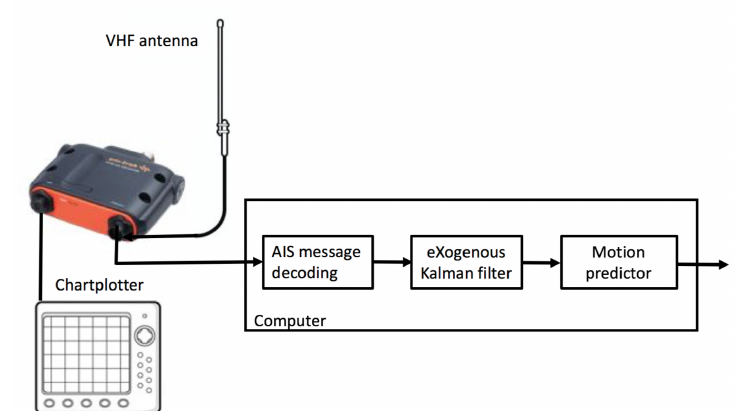
Figure 1: AIS receiver and software components for motion